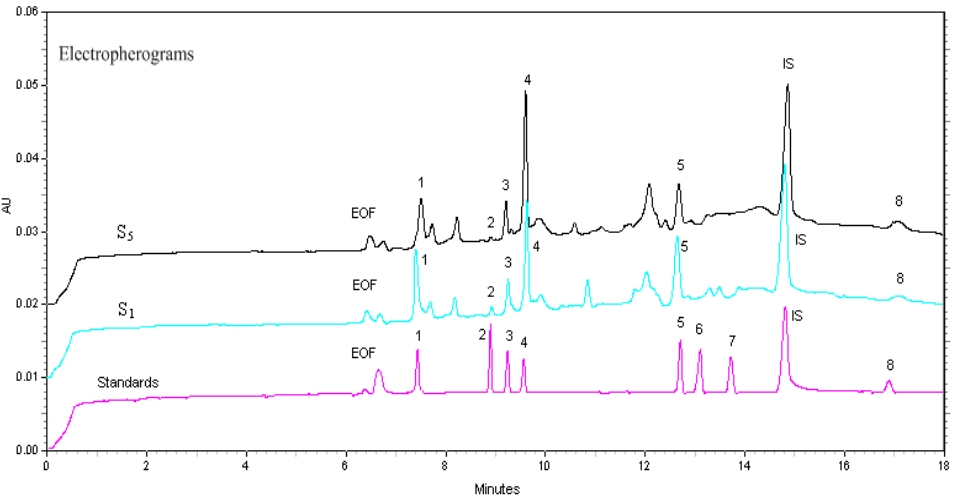
Figure 4 . Electropherograms of F. suspensa extract (S 1 ), F. suspensa fruits (S 5 ) and reference standards. Labels of compounds are the same as for Figure2, IS: internal standard.